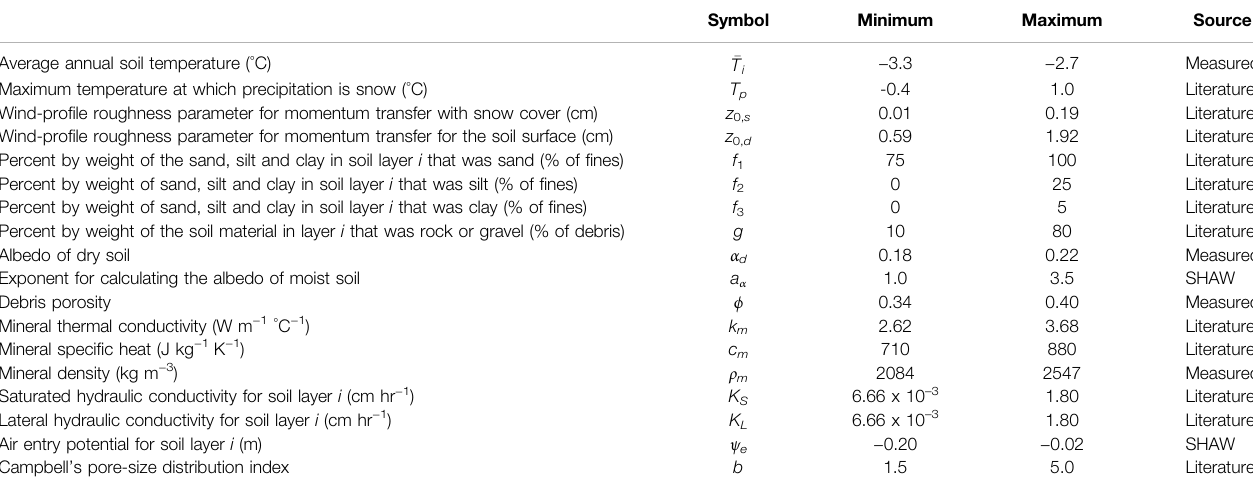
TABLE 4| TheparametersinSHAW-Glacier thatwereincluded inthesensitivity and uncertainty analysis.Theminima and maxima correspondto±10%ofmeasured values and the lower and upper quartiles of values compiled from published studies. The provenance of the values is expanded upon in the Supplementary